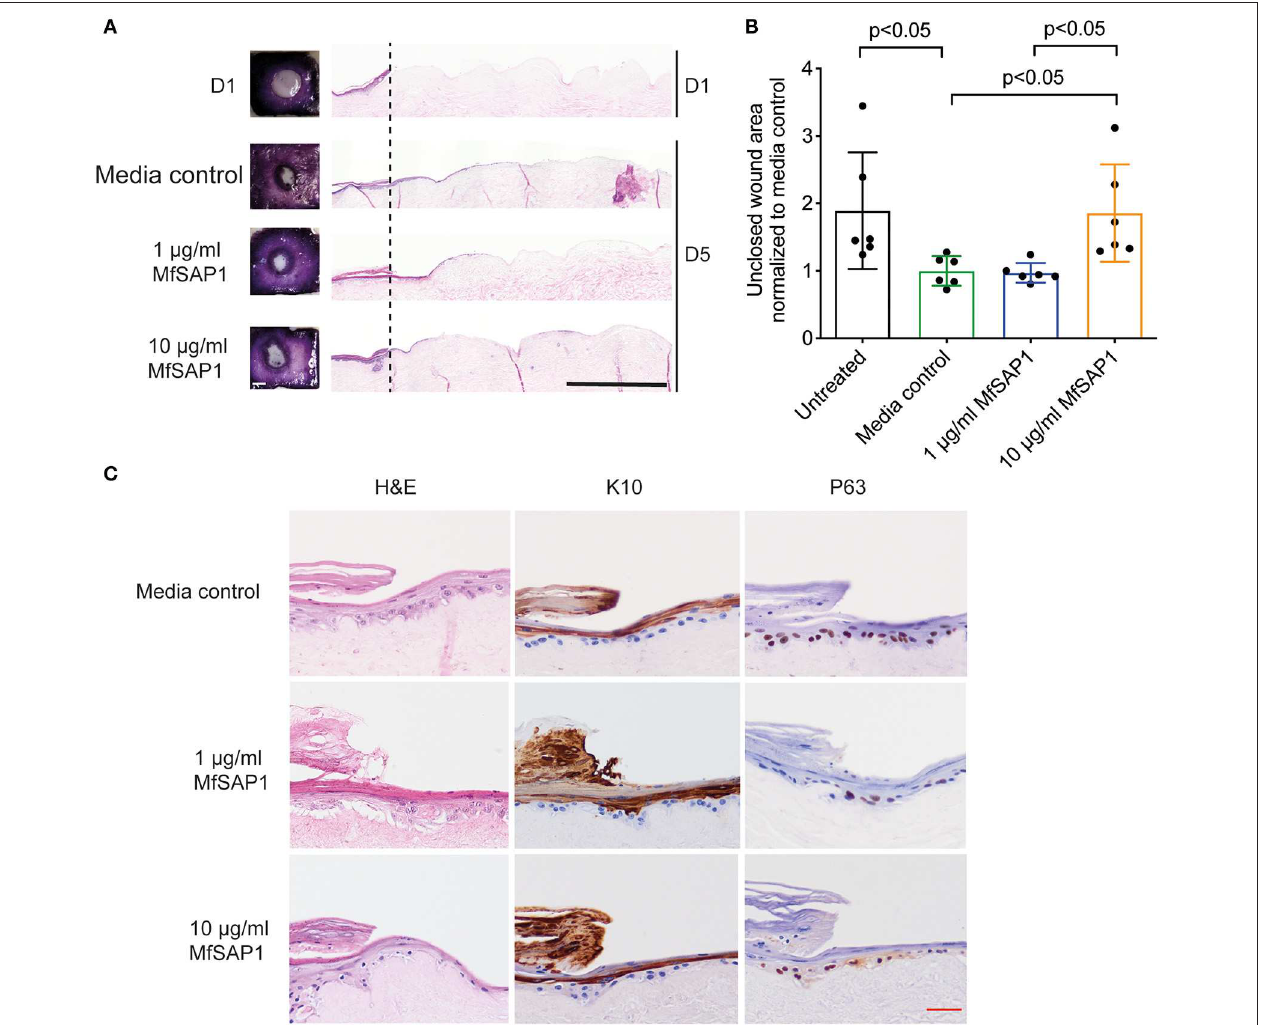
FIGURE 4 | Effect of MfSAP1 on acute wound closure. (A) MTT staining (left) and hematoxylin and eosin (H&E, right) staining of the DED-HSE sections on Day 1 and Day 5. The dashed line indicates the edge of the punch biopsy. Black scale bar, 1mm. (B) Quantification of the uncovered wound area as determined by MTT stain using ImageJ. Each wound area sample is normalized to the media control. Error bars represent standard deviation for n = 6 from a total of 3 experimental replicates with technical duplicates. (C) H&E and immunohistochemical analysis of the wound edge on Day 5 for each treatment condition. Representative images are shown from a total of 3 independent experiments. Red scale bar, 50 µ